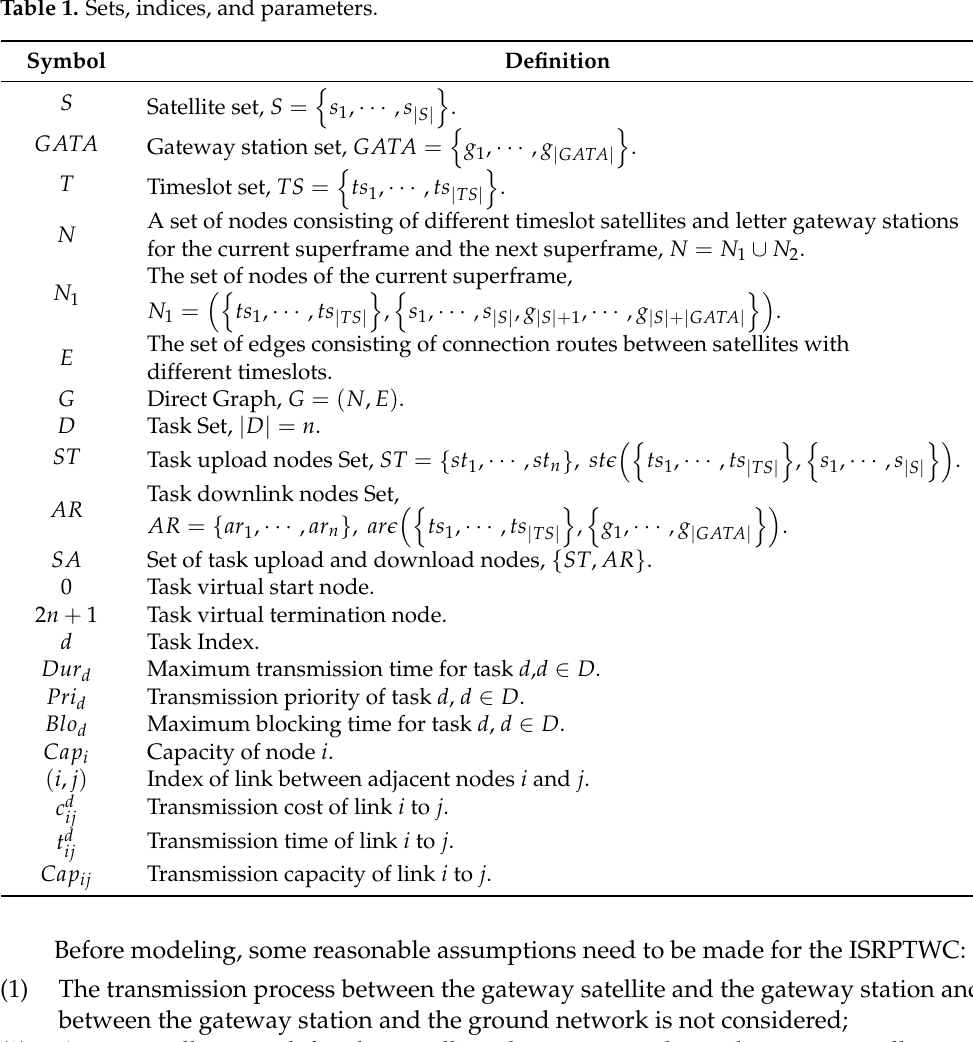
Table 1. Sets, indices, and